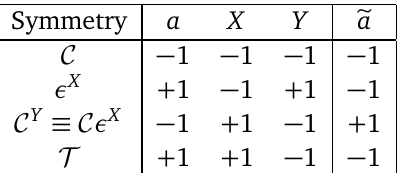
Table 2: Symmetries and their eigenvalues in U ( 1 )